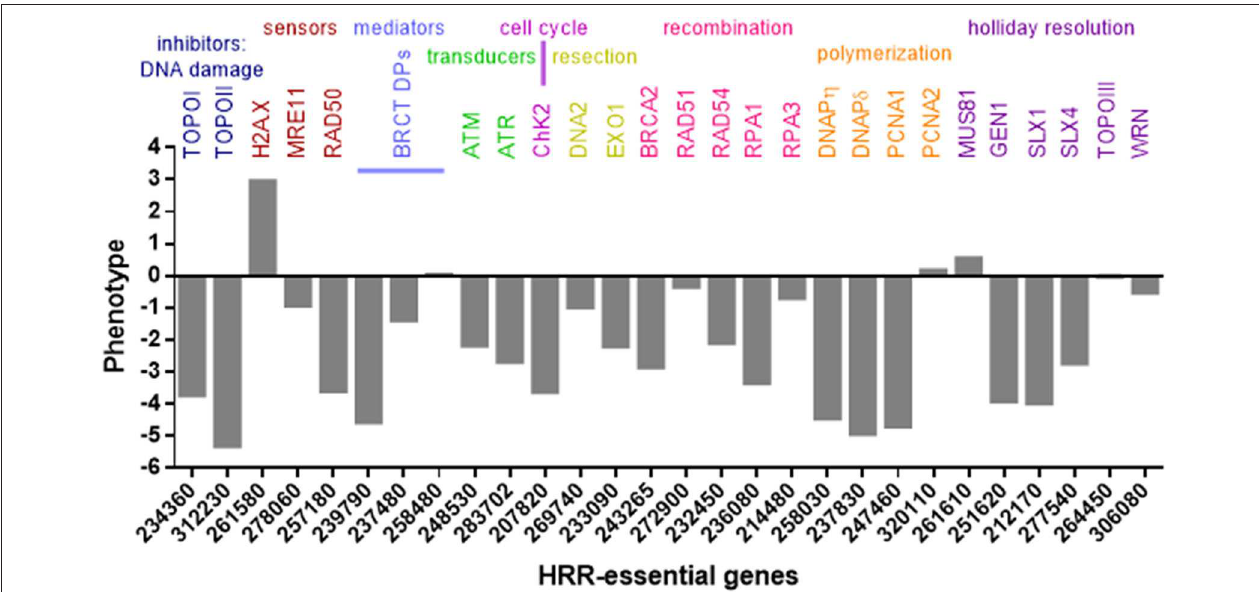
FIGURE 2 | HRR and topoisomerase genes of T. gondii . Genes were identified in www.toxodb.org and grouped according to their role in HRR pathway. In addition, phenotype scores associated with fitness were added. The score values were obtained at www.toxodb.org. The scores ranged from − 6.89 to + 2.96, where negative values indicate that the loss of the gene is disadvantaged or essential for the growth of the